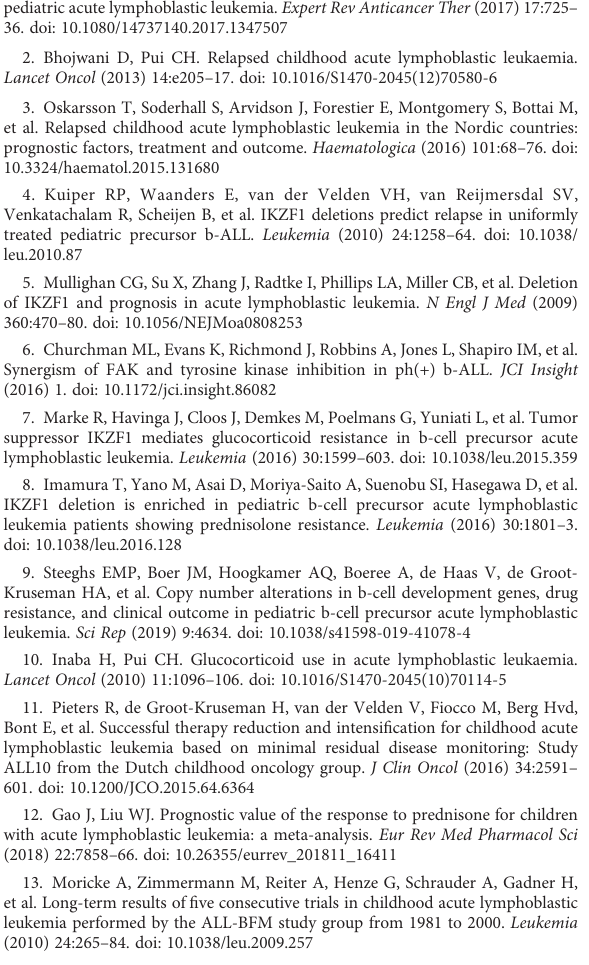
plotted. Differences were tested for signi fi cance using a student ’ s t-test (B) Quanti fi cation of cleaved PARP protein, normalized for total PARP protein expression in SEM cells wildtype or de fi cient for IKZF1 exposed to prednisolone in the presence or absence of AKT inhibitors. Differences were tested for signi fi cance using an ANOVA followed by Dunnett ’ s multiple comparisons test. SUPPLEMENTARY FIGURE 3 (A) Schematic overview representing the work fl ow used to analyze protein expression of wild-type (WT) and Ikzf1+/- mouse splenic B cells after ex-vivo treatment with prednisolone. Splenocytes were isolated and pre-stimulatedbylipopolysaccharide(LPS)for48hours,whereafterviable cells were enriched by a Ficoll gradient. Cells were then incubated for 48h with 1 m g/ml prednisolone and protein samples were taken for immunoblot analysis. (B) Immunoblot analysis of AKT and pAKT protein expression levels of LPS-activated B cells obtained from 4 mice (2 wildtype versus 2 Ikzf1 +/- mice). Actin was used as a loading control. (C) Immunoblot analysis of protein expression in SEM wt and SEM IKZF1 -/- cells after a 3d treatment of 1 m M MK2206.